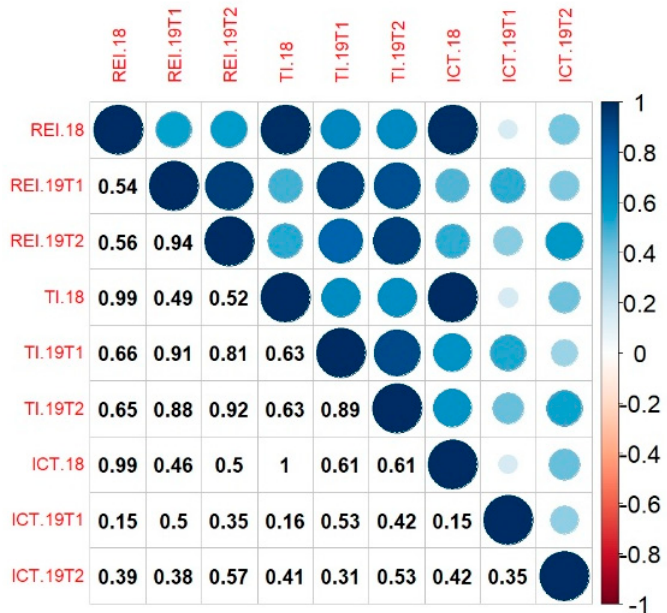
Figure 2. Correlation (r) matrix for the three types of sodicity tolerance analyses for 15 wheat lines based on: Ratio of relative predicted grain yields (REI18, REI19T1 and REI19T2), Yield Tolerance Index in 2018 and 2019 at TI or T2 (TI18, TI19T1 and TI19T2), and Yield Incremental Crop Tolerance (ICT18, ICT19T1 and ICT19T2).